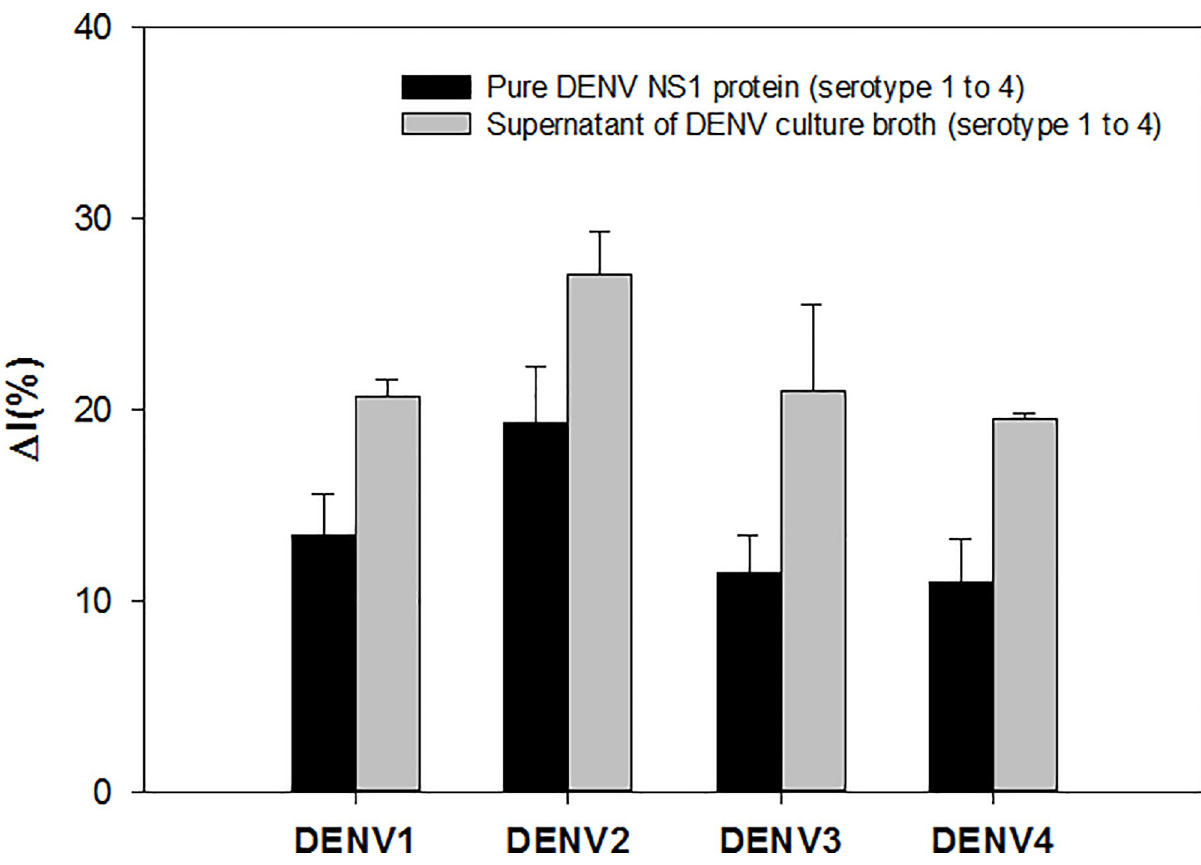
Fig 5. Relative binding affinity of DGV BP1 peptides with dengue virus (DENV) culture broth (serotype 1; DENV1, type 2; DENV2, type 3; DENV3, type 4; DENV4). Current change was measured by square wave voltammetry before and after the addition of four pure DENV nonstructural 1 (NS1) proteins (12.5 μ g/mL) and culture broth from DENV serotypes 1–4 to a DGV BP1 peptide-decorated gold electrode layer.